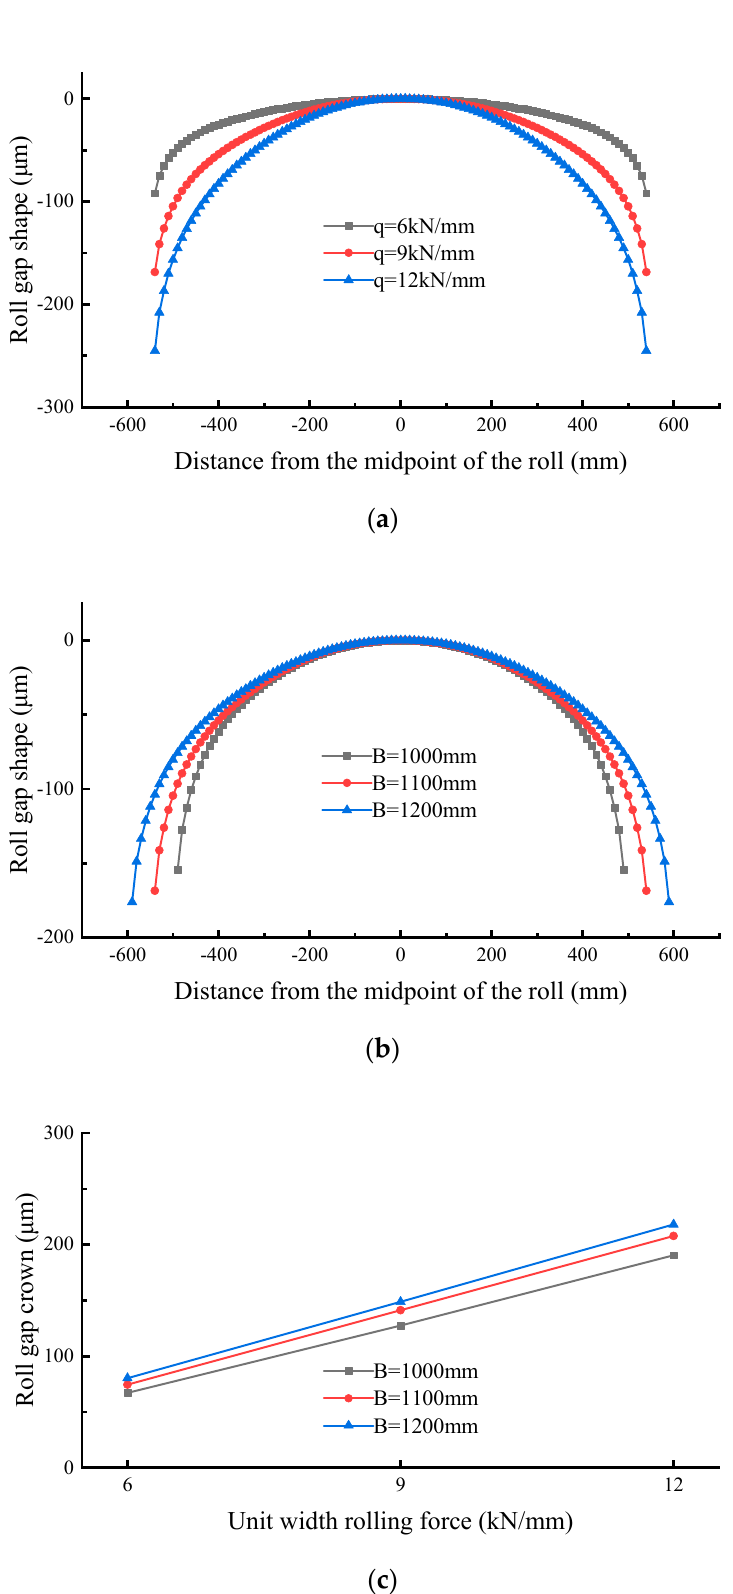
Figure 6. Effect of unit width rolling force on roll gap shape. ( a ) Roll gap shape under different unit width rolling forces, ( b ) roll gap shape of strip with different widths under the same unit width rolling force, ( c ) effect of unit width rolling force on roll gap crown.